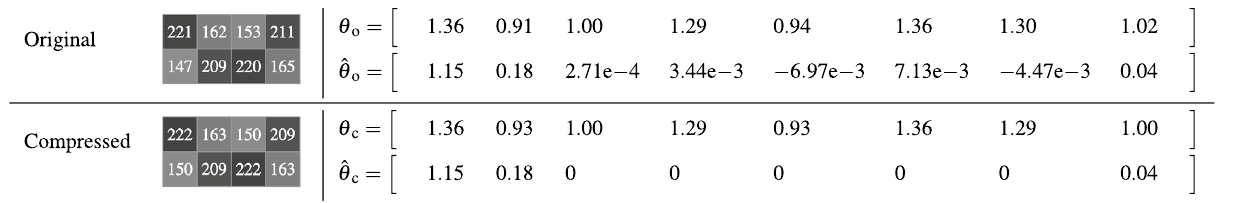
Figure 2. Compressing image data with 8 pixels arranged in a 2